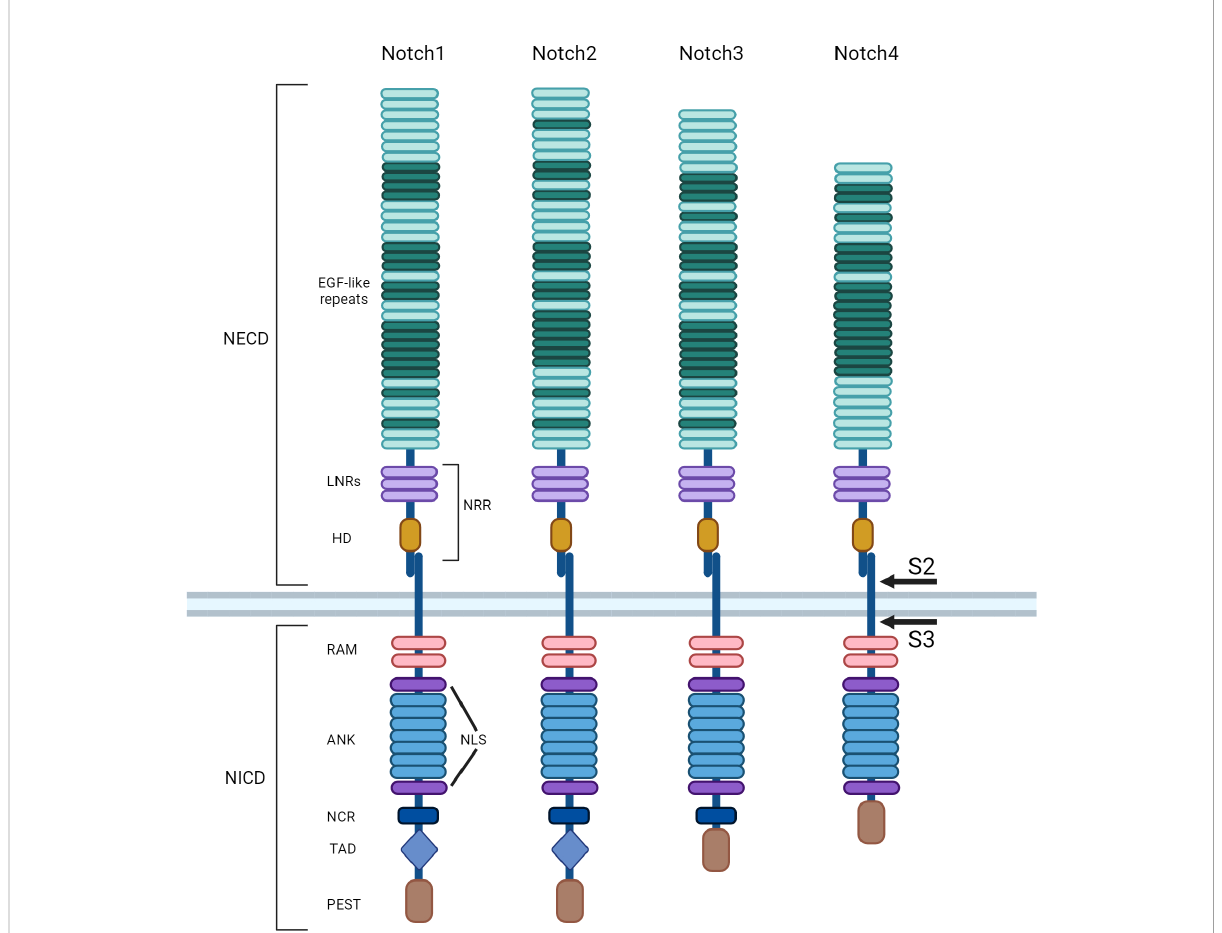
FIGURE 1 Notch receptors family. Notch receptors are single-pass type I transmembrane proteins. Mammalian cells have four Notch receptors (Notch 1- 4). Mature receptors are heterodimers comprised of an N-terminal extracellular (EC) region, non-covalently linked to a transmembrane (TM) domain and a C-terminal intracellular (IC) subunit. The N-terminal portion presents several epidermal growth factor (EGF)-like repeats, followed by a juxtamembrane negative regulatory region (NRR), which contains three Lin12/Notch repeats (LNRs) and a heterodimerization domain (HD). After the TM, the common IC portion of the receptors consists of a protein-binding RBPJ-associated molecule (RAM) and two nuclear localization sequences (NLS) interposed by seven ankyrin repeats (ANK). The Notch cytokine response region (NCR) is absent in Notch4 receptor. The transcriptional activation domain (TAD) is present only in Notch1 and 2 receptors. The last portion of all receptors is the C- terminal PEST domain, rich in proline, glutamate, serine and threonine. After ligand binding, Notch is cleaved fi rst by metalloproteases in the cleavage site S2, then it is rapidly further cleaved by the g -secretase complex in